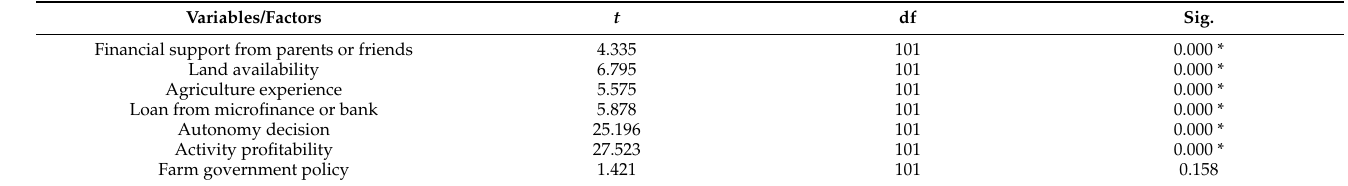
Table 7. The t -test of the effect of socioeconomic factors on agricultural entrepreneurial activities. Variables/Factors t df Sig. Financial support from parents or friends